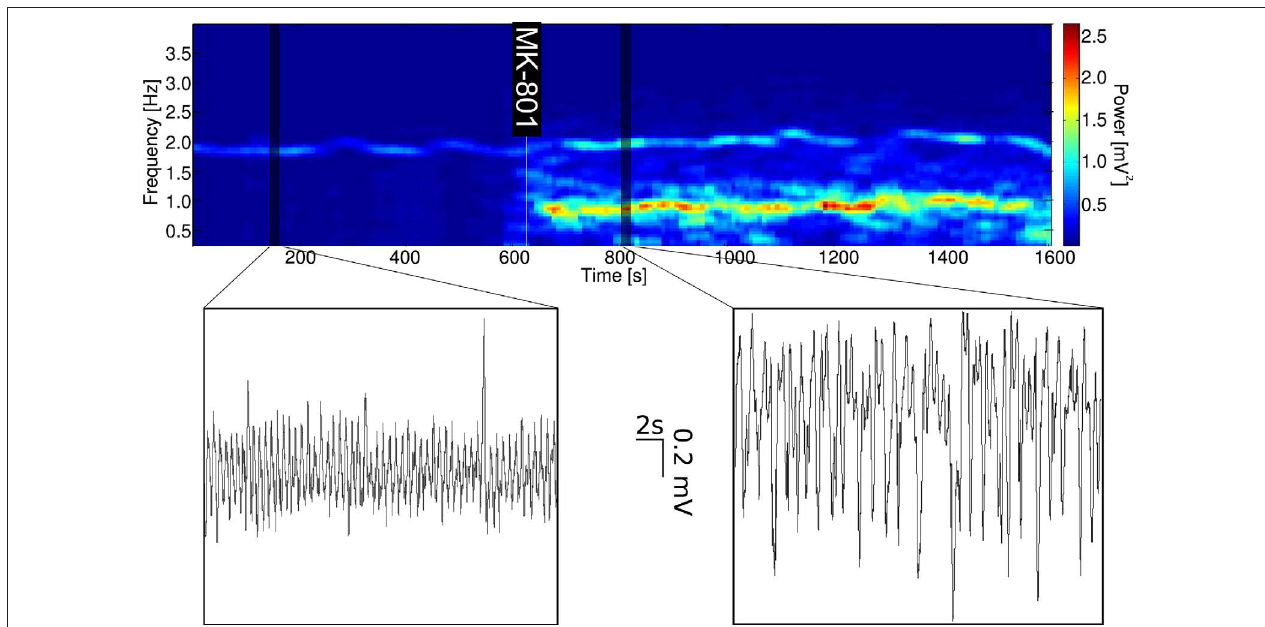
systemic MK‑801 administration include increasing the power of a lower frequency, less regular, larger amplitude oscillation (low‑delta oscillation), and